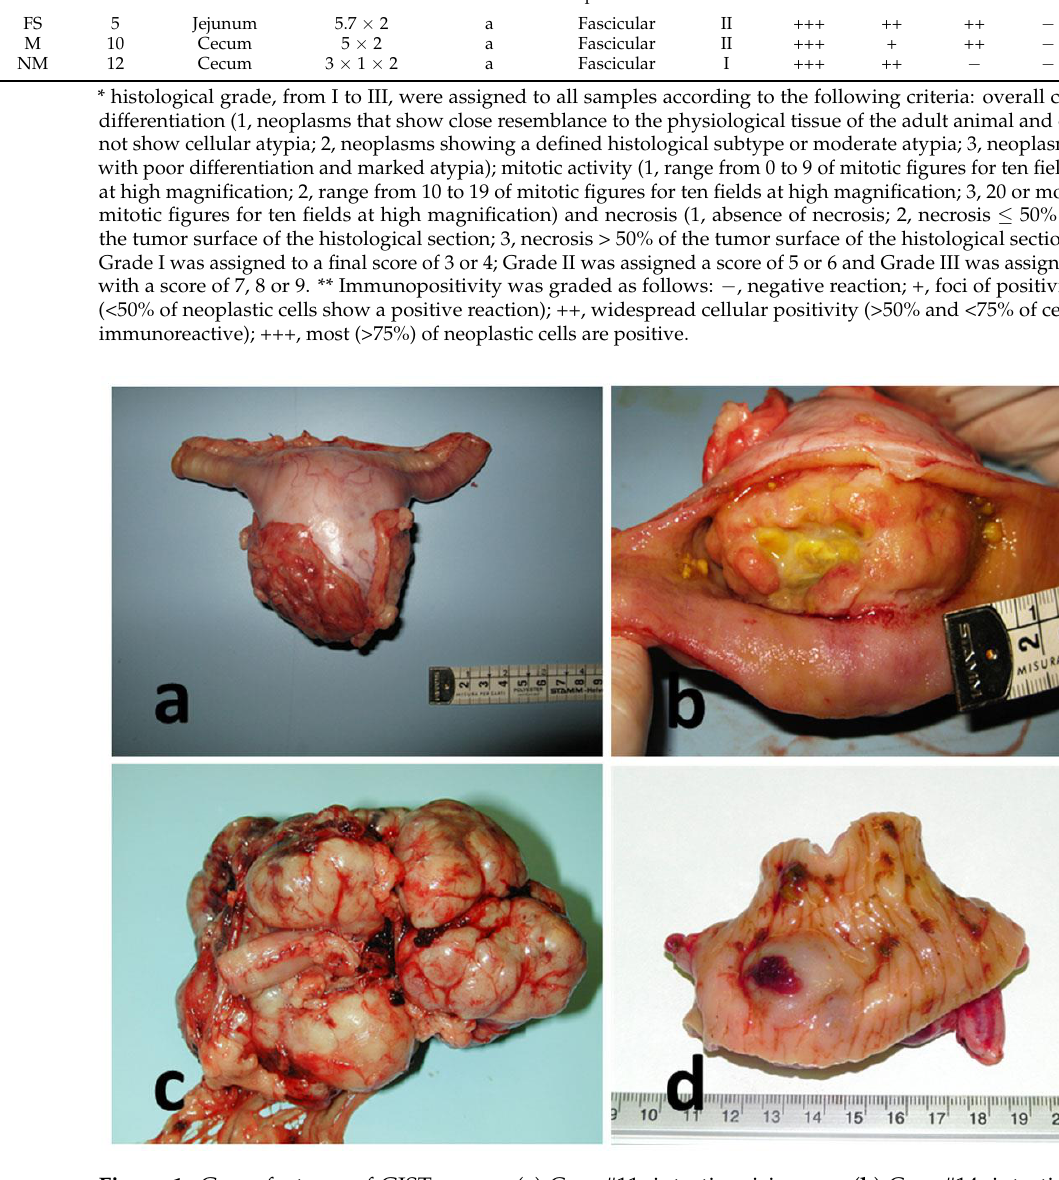
Figure 1. Gross features of GISTs cases. ( a ) Case #11, intestine, jejunum. ( b ) Case #14, intestine, duodenum. ( c ) Case #10, intestine, ileum; ( d ) Case #16, intestine, cecum.